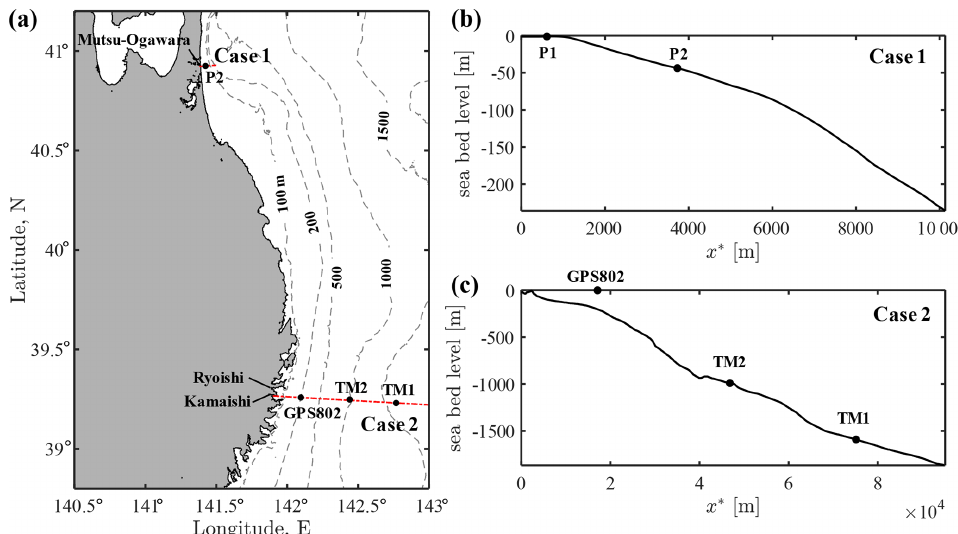
Figure 7. Map of the case study sites and wave observation stations for the 2011 Tohoku tsunami: (a) overview of the two case study sites at the northeastern Pacific coast of Japan and (b) and (c) seabed profiles along the cross-shore transects for Case 1 and Case 2, respectively. The markers indicate the locations of wave observation points.